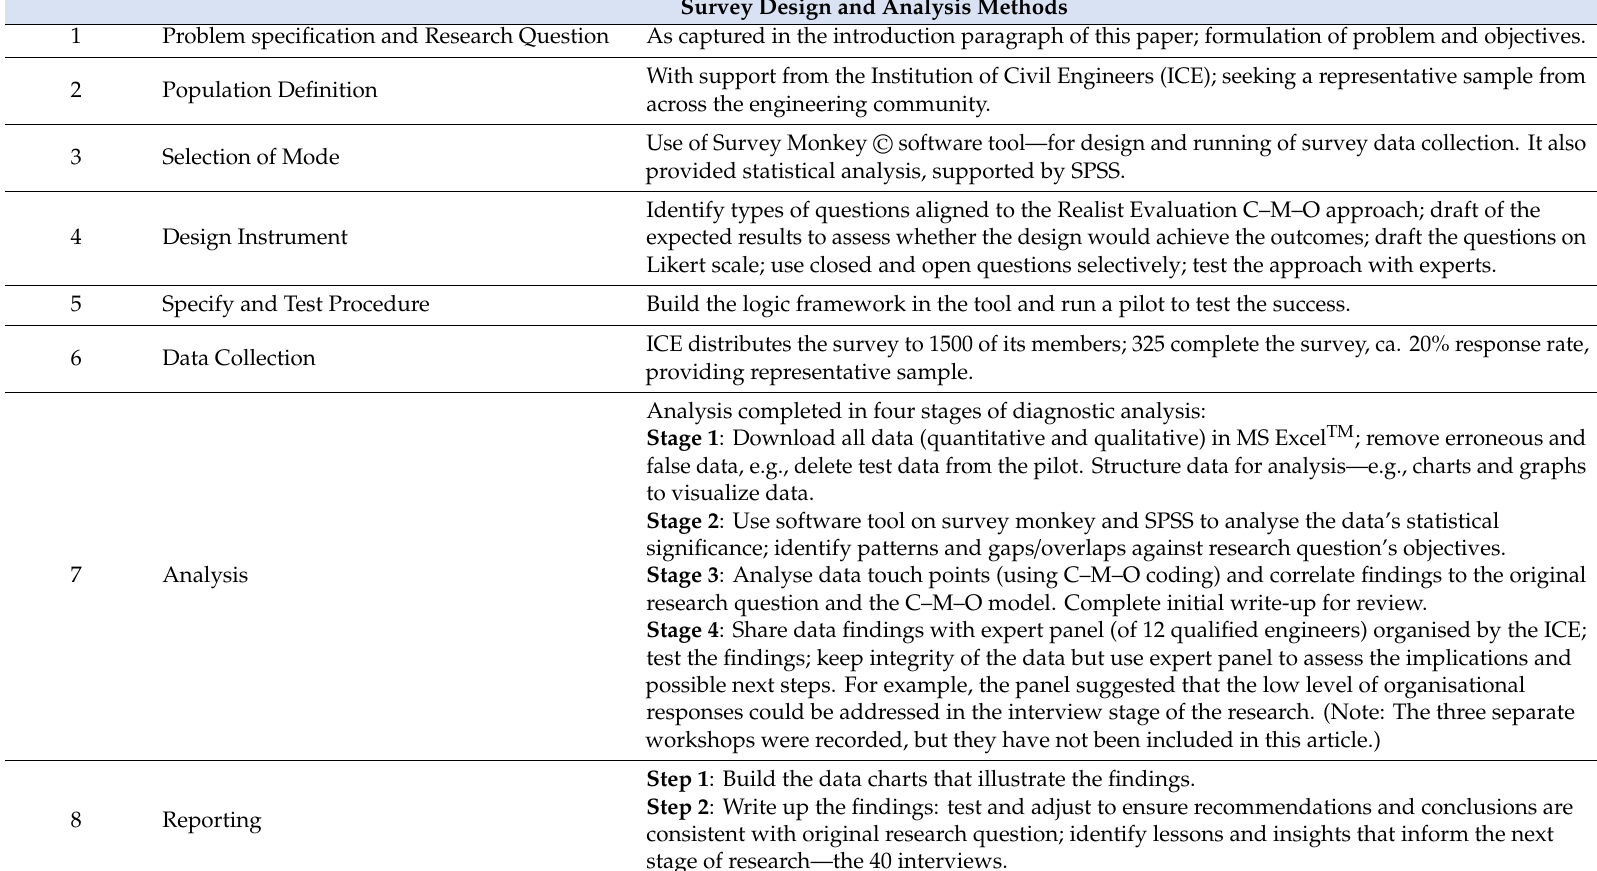
Table 2. Analysis method adopted (adapted from: Creswell and Creswell 2017; Nardi